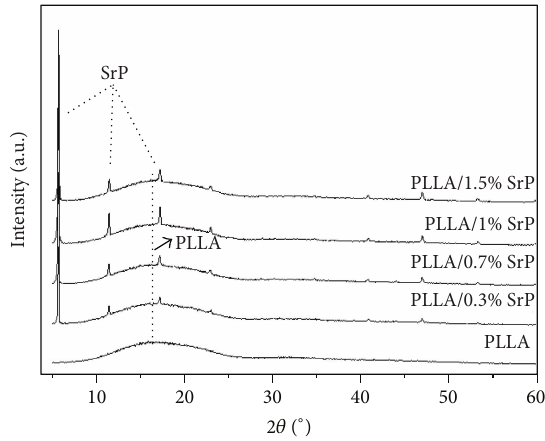
Figure 6: XRD curves of PLLA and PLLA/SrP after melting blend.